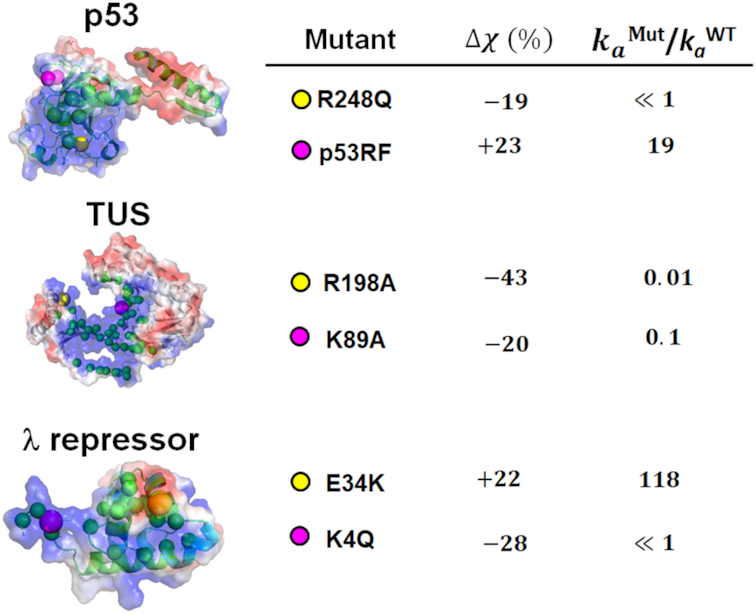
The effect of mutations on the kinetics of DNA recognition can be explained by a change in the frustration. The kinetics of binding to a specific site on DNA was analyzed for six mutants of three different proteins (P53, TUS and \documentclass[12pt]{minimal}
\usepackage{amsmath}
\usepackage{wasysym}
\usepackage{amsfonts}
\usepackage{amssymb}
\usepackage{amsbsy}
\usepackage{upgreek}
\usepackage{mathrsfs}
\setlength{\oddsidemargin}{-69pt}
\begin{document}
}{}${\rm{\lambda }}$\end{document} repressor proteins). The electrostatic potential of each of the three proteins is shown. In each protein, the residues that participate in specific contacts with DNA (green beads) as well as the mutated sites (yellow and magnetite beads) are shown. The mutants are analyzed in terms of the change in the similarity index, Δχ, in comparison with the wild-type protein and with respect to the association rate relative to the wild-type protein, kaMut/kaWT. Association rate values are taken from (59,66,68). The PDB codes used to calculate the similarity index: P53RF (4MZRa), P53wt (3Q05), TUS (1ECR) and \documentclass[12pt]{minimal}
\usepackage{amsmath}
\usepackage{wasysym}
\usepackage{amsfonts}
\usepackage{amssymb}
\usepackage{amsbsy}
\usepackage{upgreek}
\usepackage{mathrsfs}
\setlength{\oddsidemargin}{-69pt}
\begin{document}
}{}${\rm{\lambda }}$\end{document} repressor (1LMB).